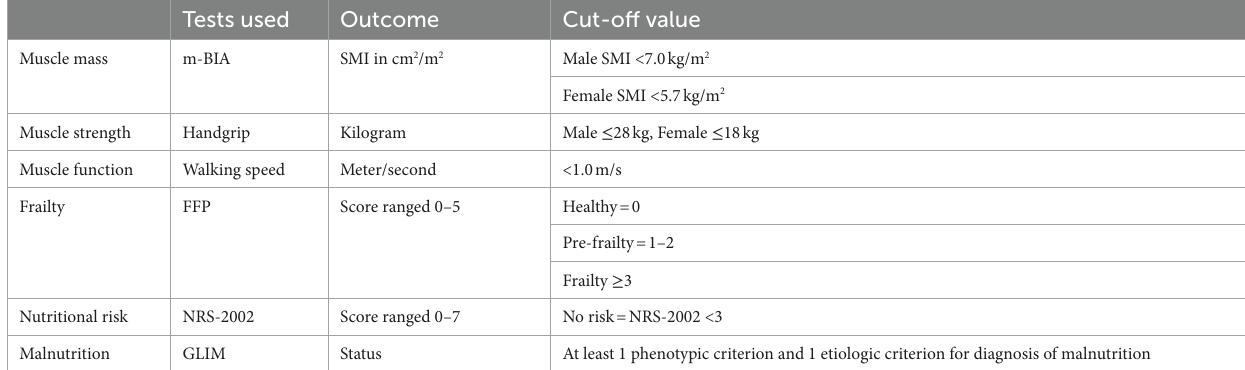
TABLE 1 Domains and corresponding screening tools with applied cut-off values (13, 14,